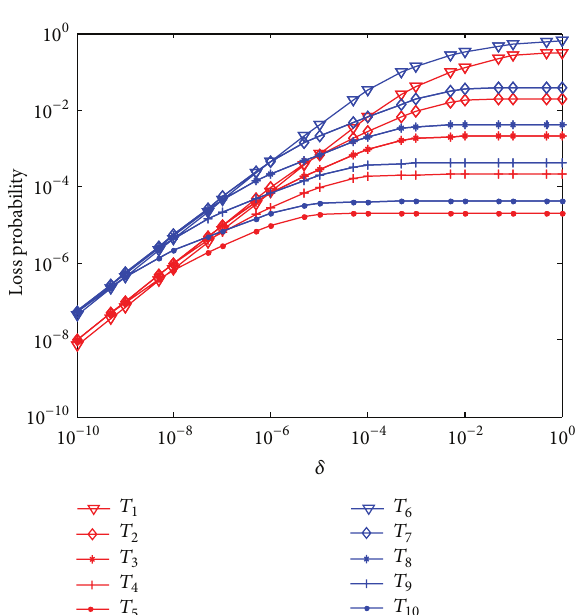
Figure 12: Loss probability versus 𝛿